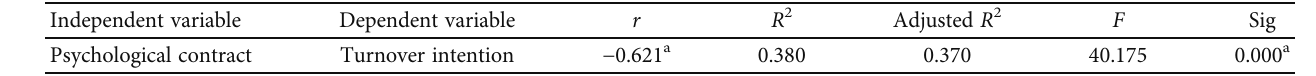
Table 5: Regression analysis of psychological contract on turnover intention.